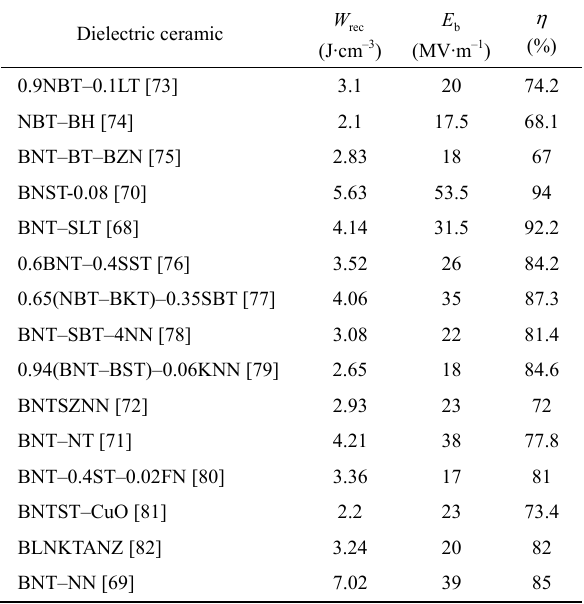
Energy-storage properties of BNT-based relaxor ferroelectric bulk ceramics Dielectric